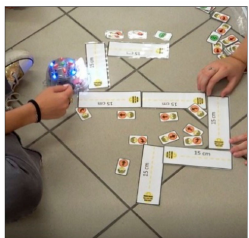
Figure 4. Inappropriate use of the programming cards.